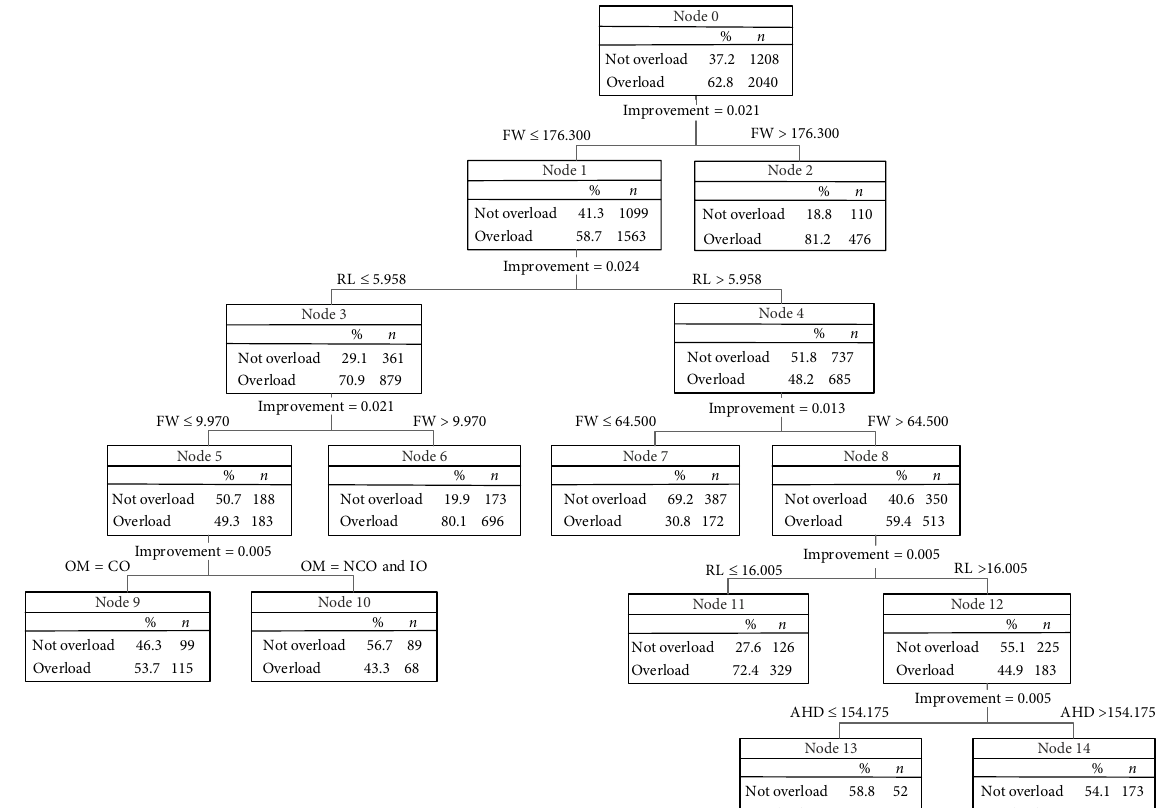
Figure 2. Results of CART